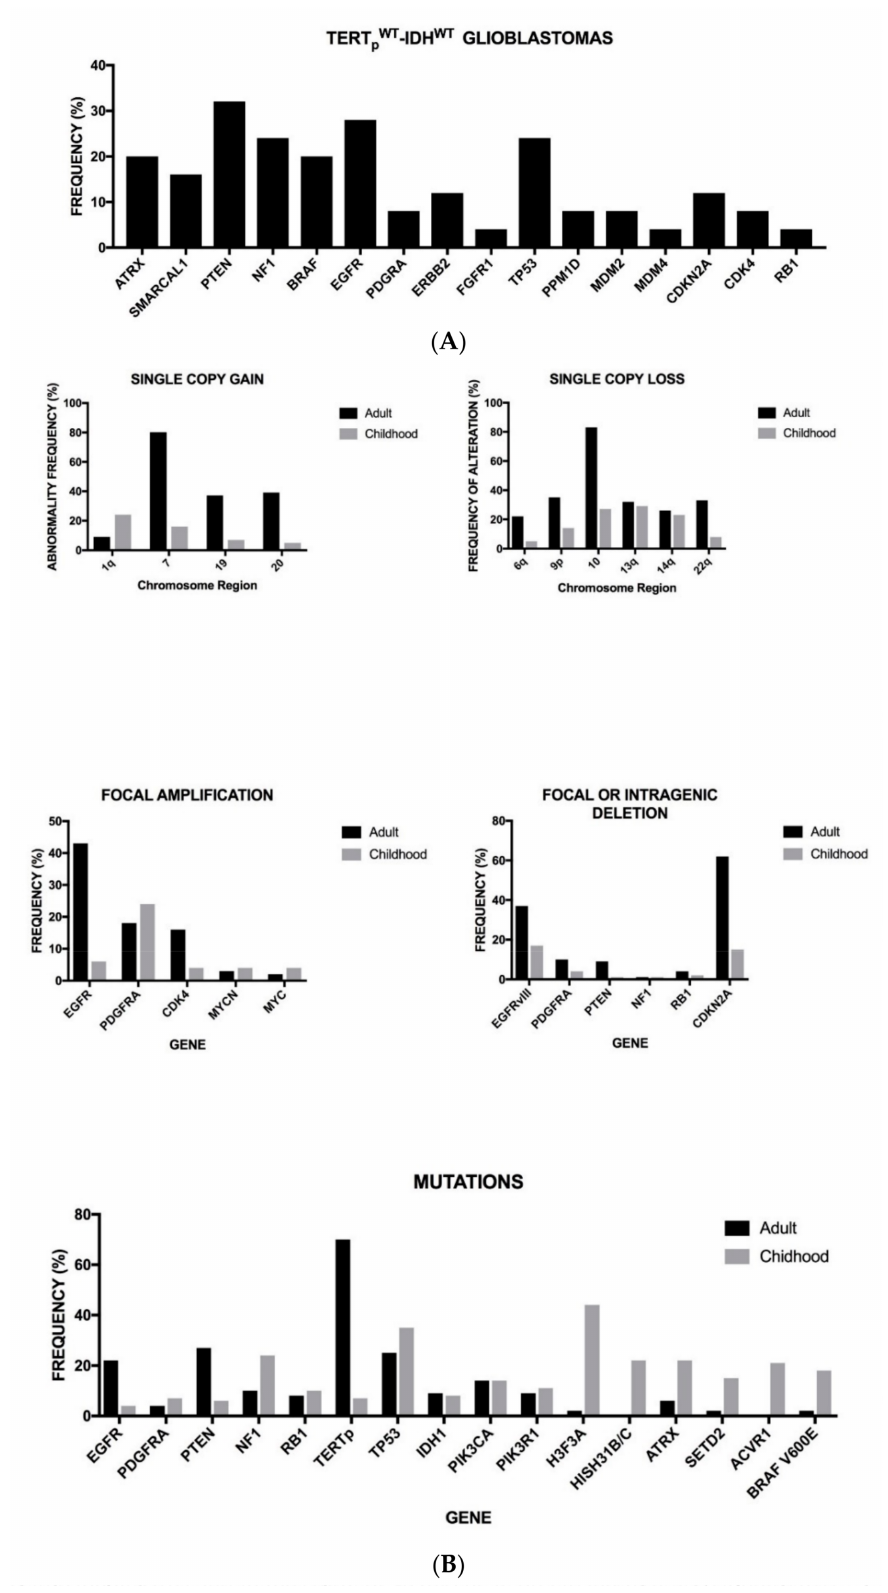
Figure 1. ( A ) Main genetic abnormalities observed in TERTp WT -IDH WT glioblastomas. Data are reported in Diplas et al., 2018 [19]. ( B ) Recurrent somatic alterations reported in adult and pediatric glioblastomas. H3F3A mutations correspond to the cumulative frequency of three types of mutations: H3F3A G34R , H3F3A G34V , and H3F3A K27M . The HIST1H3B mutations correspond to the cumulative incidence of HIST1H3B K27M and HIST1H3C K27M . The data are reported in Sturm et al., 2017